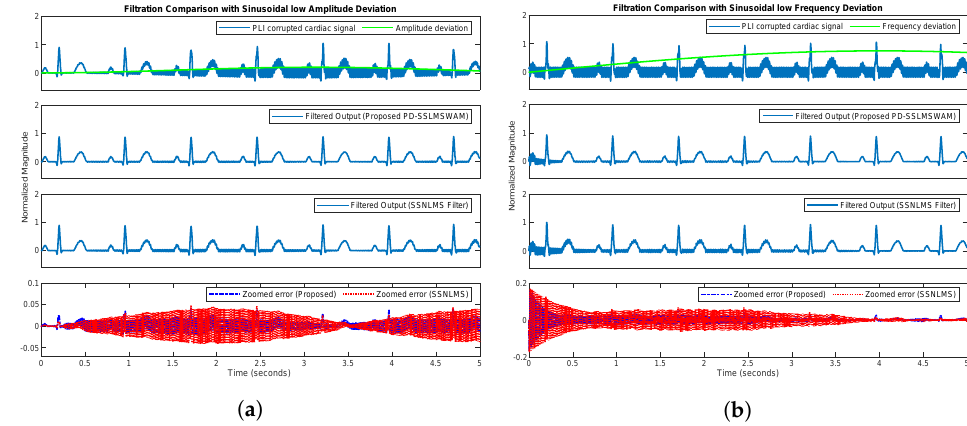
Figure 12. Filtration comparison between the proposed PD–SSLMSWAM and SSNLMS adaptive filters for PLI-corrupted cardiac signals.( a ) Sinusoidal low change in amplitude; ( b ) sinusoidal low change in frequency of the composite PLI